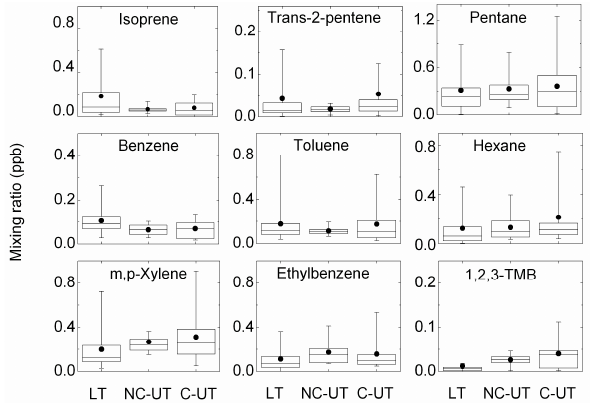
Fig. 6. Selected NMHC variability in the low troposphere (LT) (94 data points), in non-convective UT (NC-UT) (34 data points) and in convective UT (C-UT) (25 data points). Lower and upper limits of the box correspond to 25% and 75% percentiles, bottom and top whiskers the 10% and 90%. Middle bars indicate the median and black dots the mean.